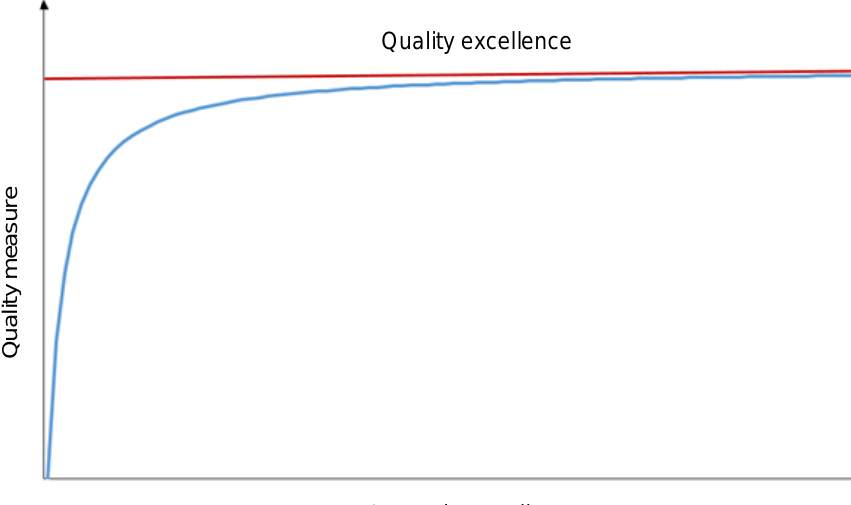
Figure 15. Illustration of the process of improving quality as a pursuit of excellence [3].